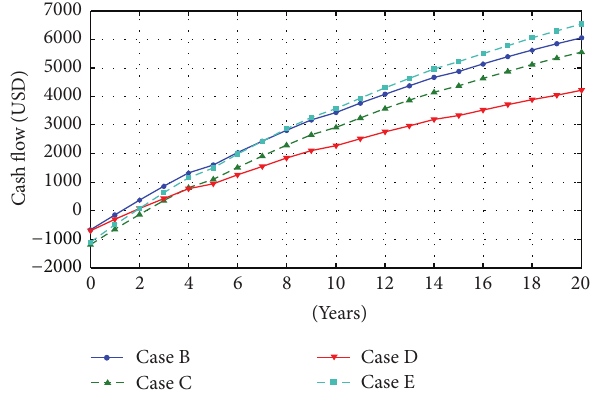
Figure 7: Effect of interest rate on cash flow analysis for four different cases.